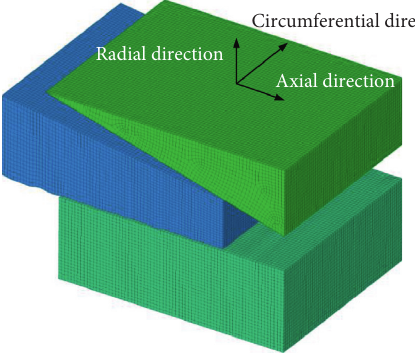
Figure 3: Multiscale model of pipeline fittings. Table. 1: Material properties of pipeline